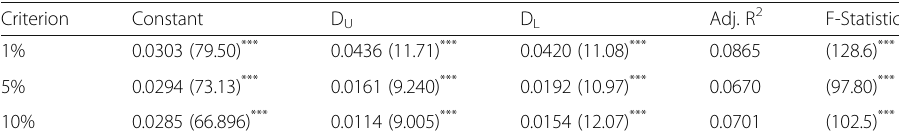
Table 2 Regression of CSSD t Criterion